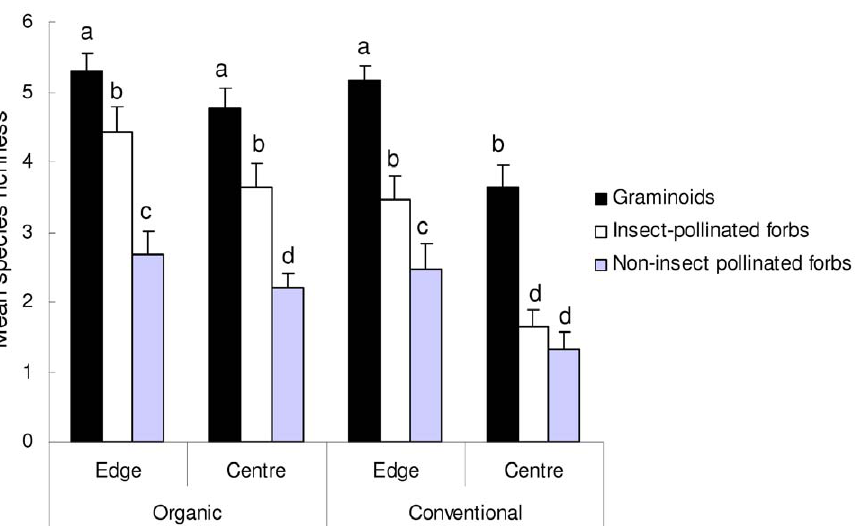
Figure 2. Mean ( ± standard error) graminoid/forb richness per transect in organic/conventional field edges and centres. Letters above the bars indicate significant differences among plant groups, farm type and edge/centre, using Linear Mixed Effects Models.